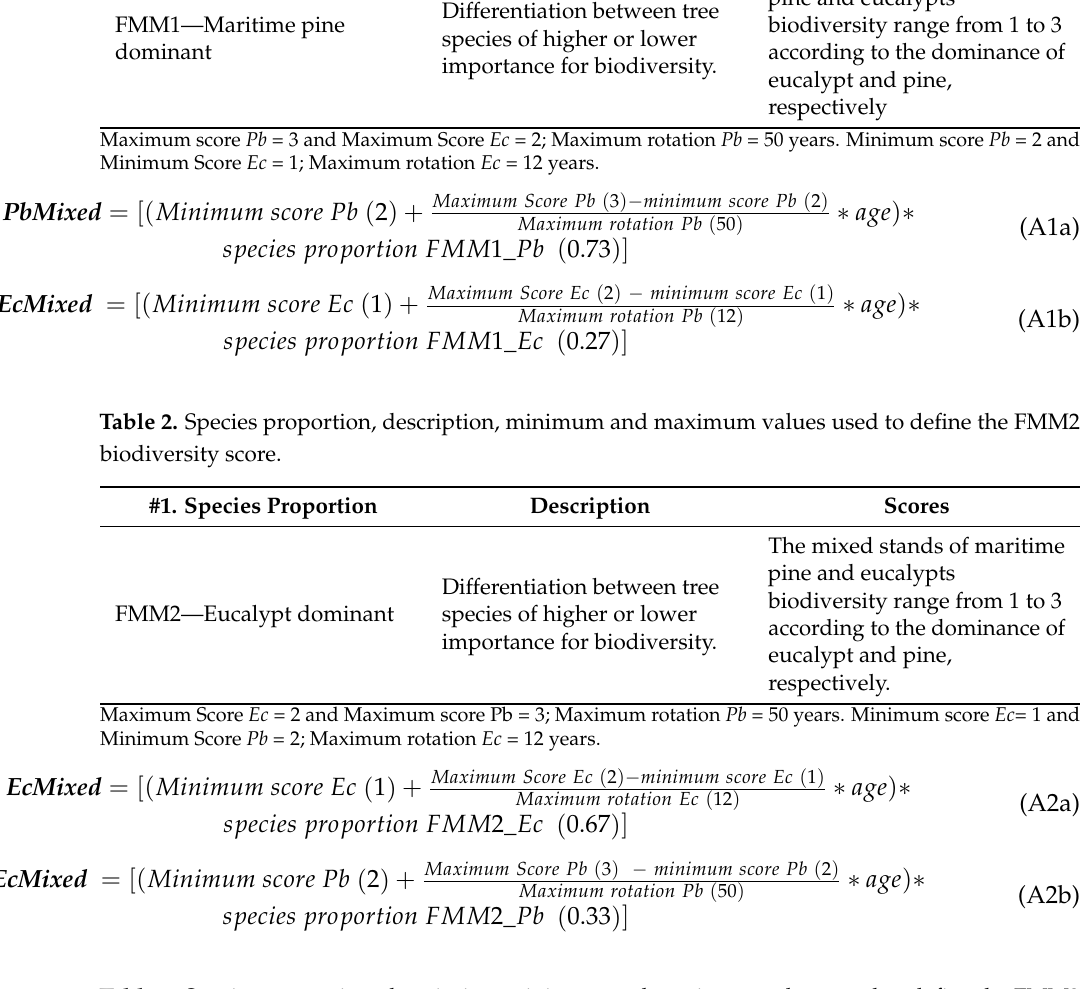
Table A1. Species proportion, description, minimum and maximum values used to define the FMM1 biodiversity score. #1. Species Proportion Description Scores Differentiation between tree FMM1—Maritime pine species of higher or lower dominant importance for biodiversity.